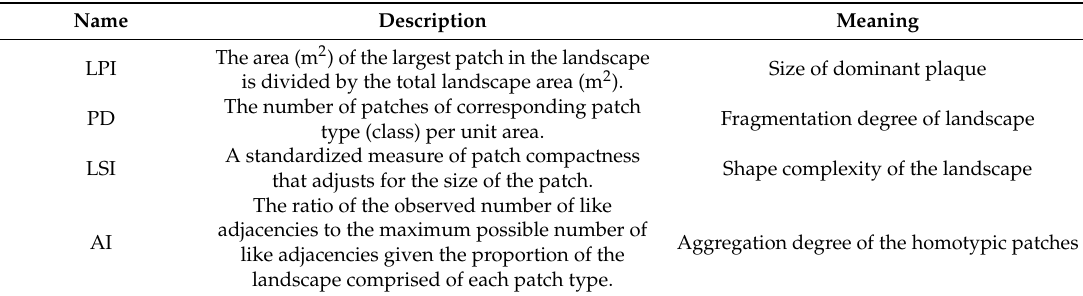
Table 6. Landscape index and descriptions [43].